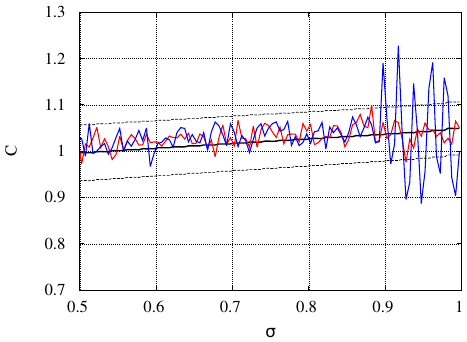
Figure 10. Normalised distribution of particles for the 3-D exper- Fig. 10. Normalized distribution of particles for the 3D experiment. iment. The initial distribution ∝ h ρ i (black) and the final distribu- The initial distribution ∝h ρ i (black) and the final distributions ob- tions obtained using the A interpolation scheme (red) and the D in- tained using the A interpolation scheme (red) and the D interpo- lation scheme (blue). Dashed lines show the limit of 3 standard terpolation scheme (blue). Dashed lines show the limit of 3 standard deviation around the initial distribution. deviations around the initial